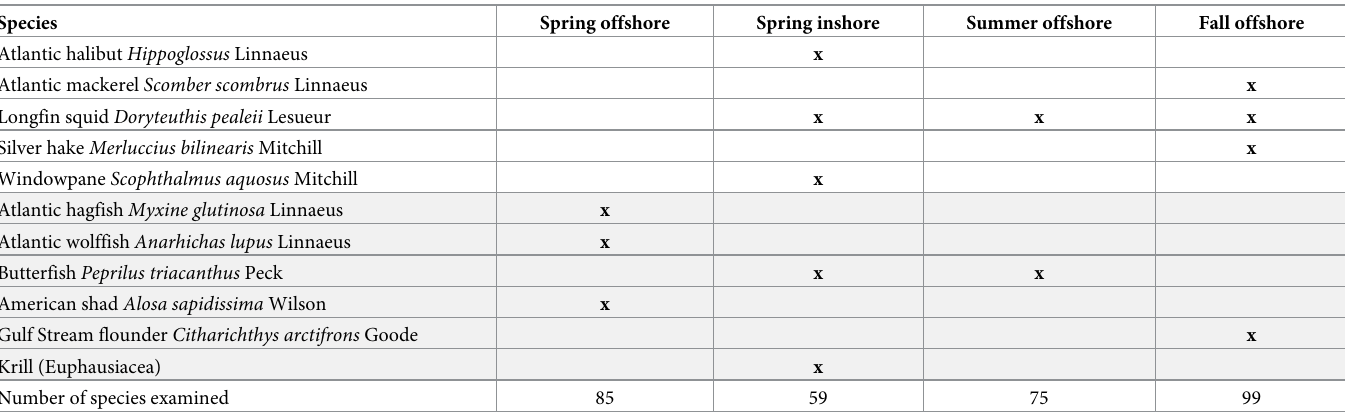
Table 2. Species with peaks in relative biomass indices in